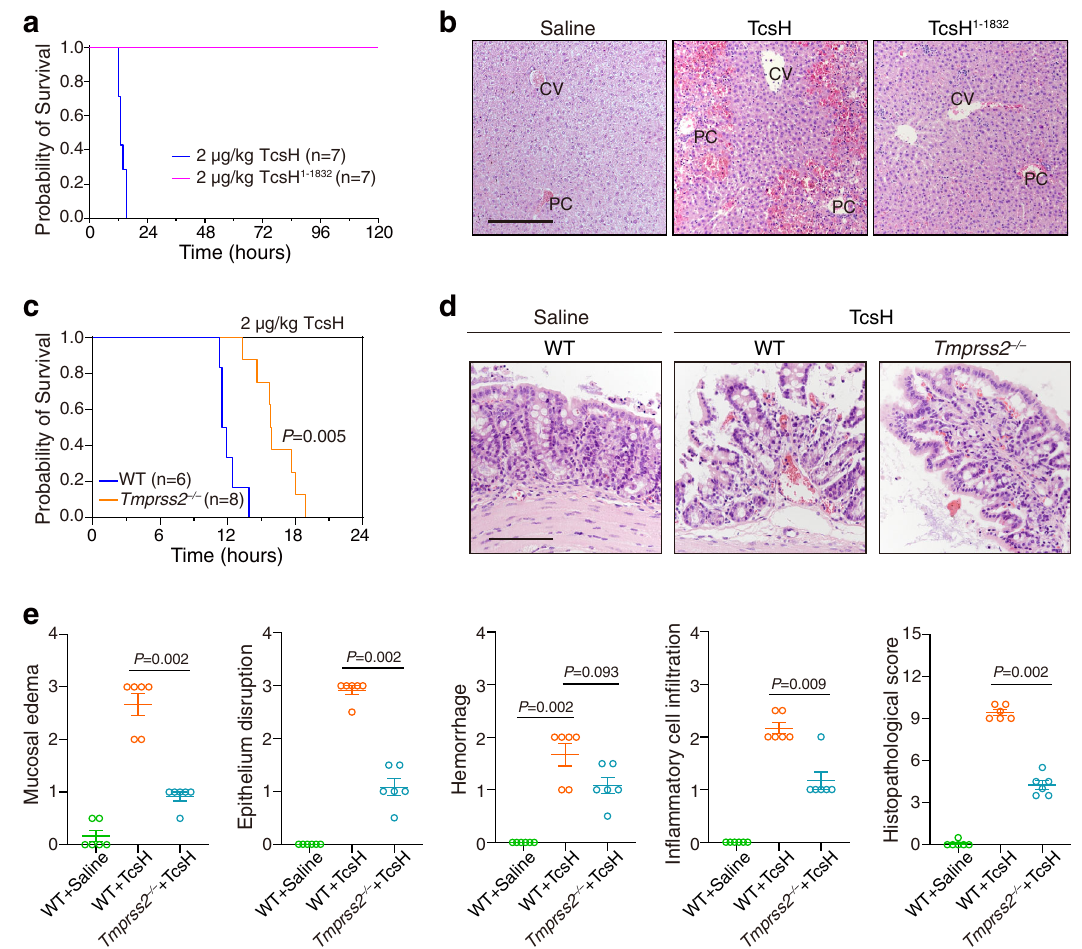
Fig. 5 | TMPRSS2 is responsible for TcsH-induced colonic lesions. a Kaplan – Meier curves show the survival of C57BL/6 WT mice intravenously injected with 2 μ g/kg TcsH or TcsH 1 – 1832 , respectively. b Mouse liver tissues har- vested 8h post tail vein injection of 2 μ g/kg TcsH or TcsH 1 – 1832 . Representative images for the H&E-stained liver sections are from one of three independent experiments (CV: central vein, PC: portal vein). The scale bar represents 200 μ m. c Kaplan – MeiercurvesshowthesurvivalofC57BL/6WTor Tmprss2 ‒ / ‒ miceinjected with 2 μ g/kg TcsH, respectively. Log-rank (Mantel – Cox) test. d Mouse colonic